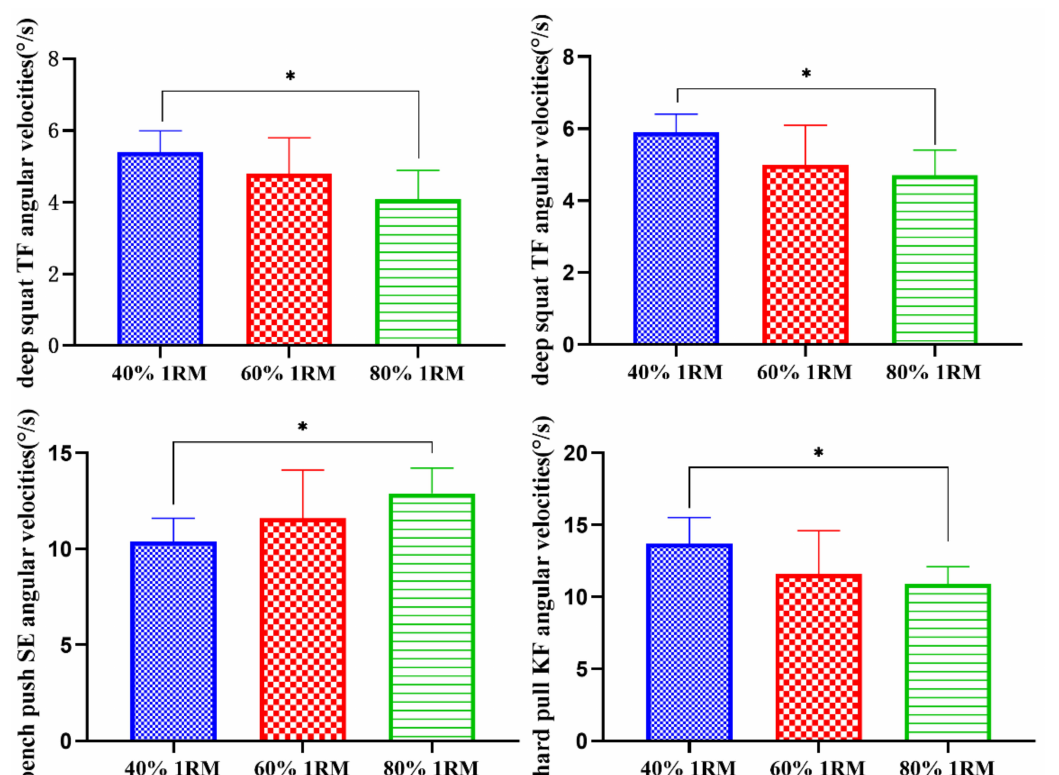
Figure 5. Comparisons of the different load intensity test angular velocities ( ◦ /s). * There was a significant difference between 40% 1RM and 80% 1RM ( p <